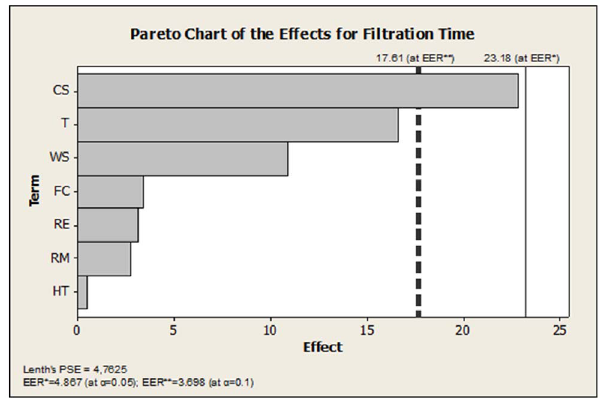
Figure 6. Pareto chart of the effects with assorted EER critical limits according to corrected Lenth method due to Ye and Hamada [ 49 ] .